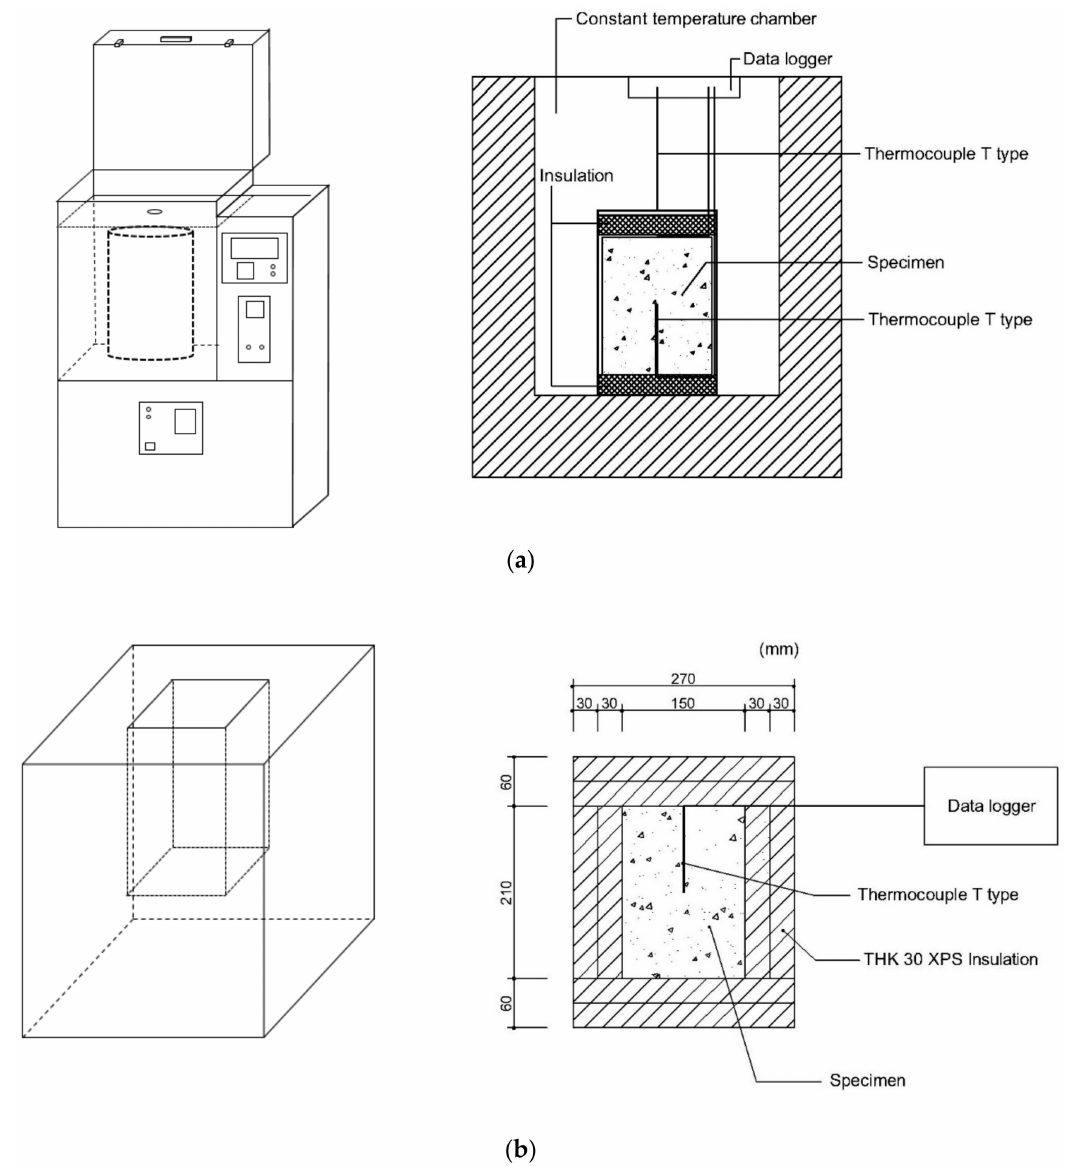
Figure 2. Schematic diagrams of ( a ) adiabatic and ( b ) semi-adiabatic